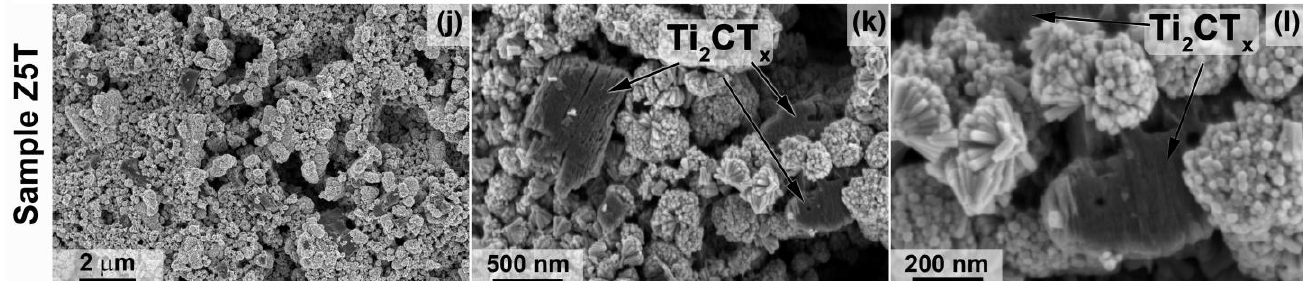
Figure 6. Microstructure of the receptor layers of samples Z ( a – c ), Z1T ( d – f ), Z3T ( g – i ) and Z5T ( j – l ) deposited on a sensor substrate by microplotter printing, as determined by SEM.